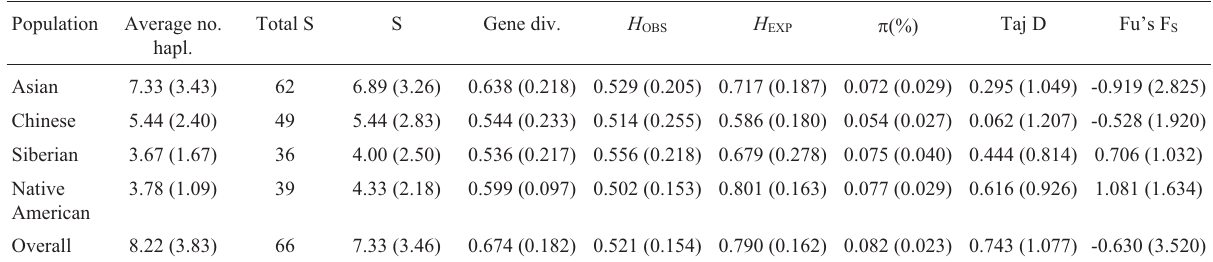
Table 1 - Average genetic diversity statistics over loci. Standard deviation values are shown in parentheses and are calculated over loci 1 . Population Average no. hapl.